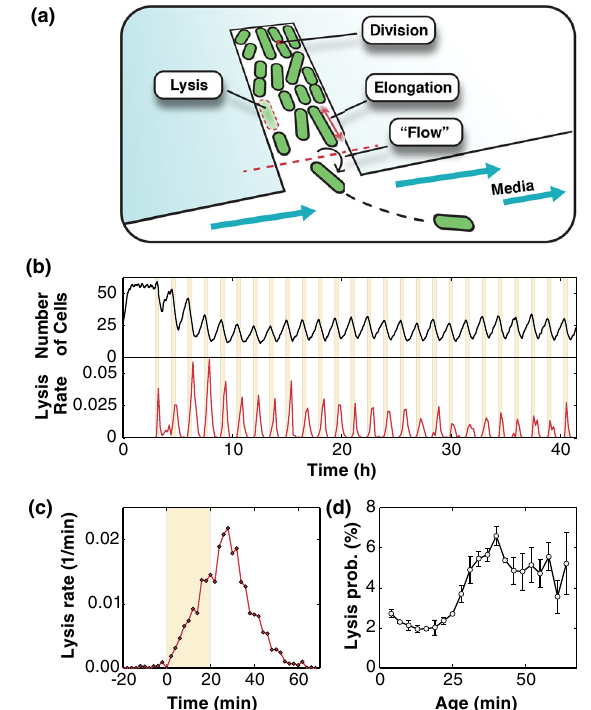
FIG. 2. Lytic response to carbenicillin antibiotics. (a) Schematic representation of the microfluidics device, where cells confined to growth chambers can be monitored for hundreds of generations. (b) The number of cells decreases sharply following each 100 μ g = mL carbenicillin treatment. The measured lysis rate is also in phase with the antibiotic treatments. (c) Average lysis rate in response to each 20-min treatment of carbenicillin (number of treatments is 25). The lysis rate peaks approximately 10 min after antibiotic removal. (d) The rate of cell lysis increases with cell age (mean (cid:4) s : d : , n ¼ 3